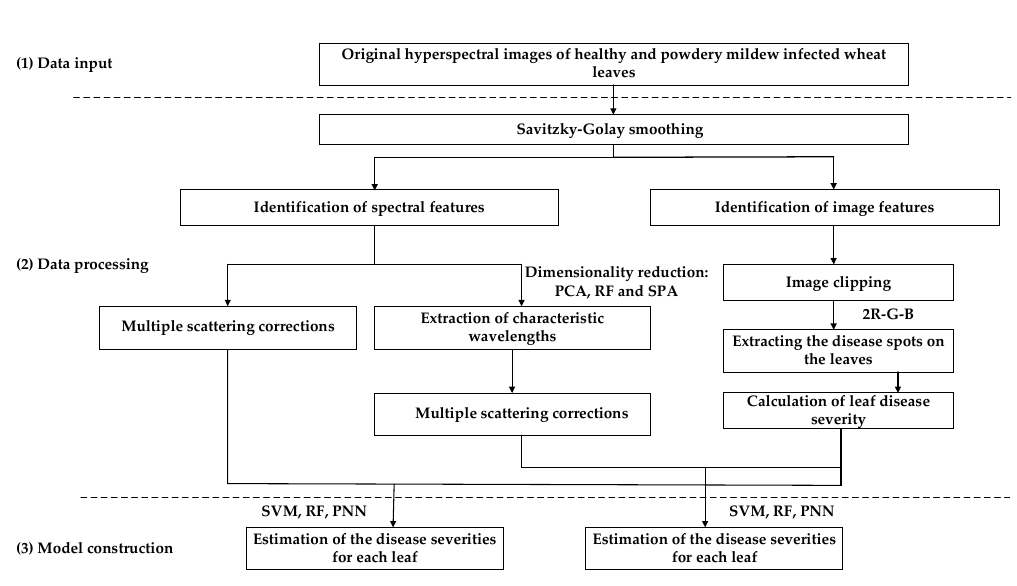
Figure 1. The overall technical workflow of the study.